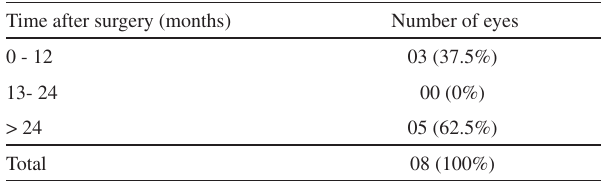
Table 2 - Success and failure correlated with age